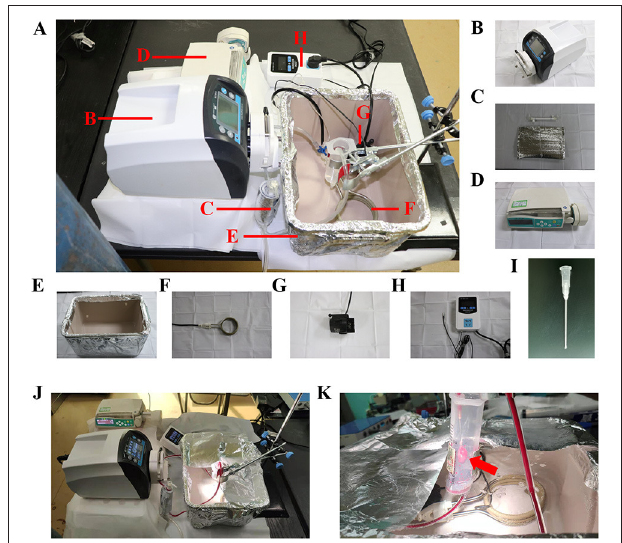
FIGURE 2 | ESHP system. (A) Schematic figure of the ESHP system; (B) Micro-peristaltic pump; (C) Oxygenator; (D) Infusion syringe pump; (E) Water-bath box; (F) Heater; (G) Stirrer; (H) Temperature-controlling switch; (I) Aortic catheter; (J) Working ESHP system; (K) Beating heart (Red arrow). ESHP, Ex situ heart perfusion.